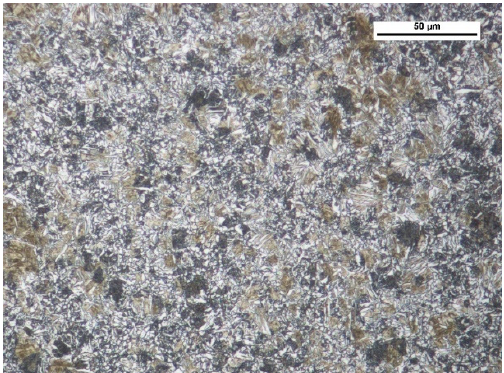
Figure 4. B27 steel microstructure—semi-martensitic with fine carbide grains. Magnitude ×1000, etched with 3% HNO 3 (Mi1Fe), scanning microscopy.